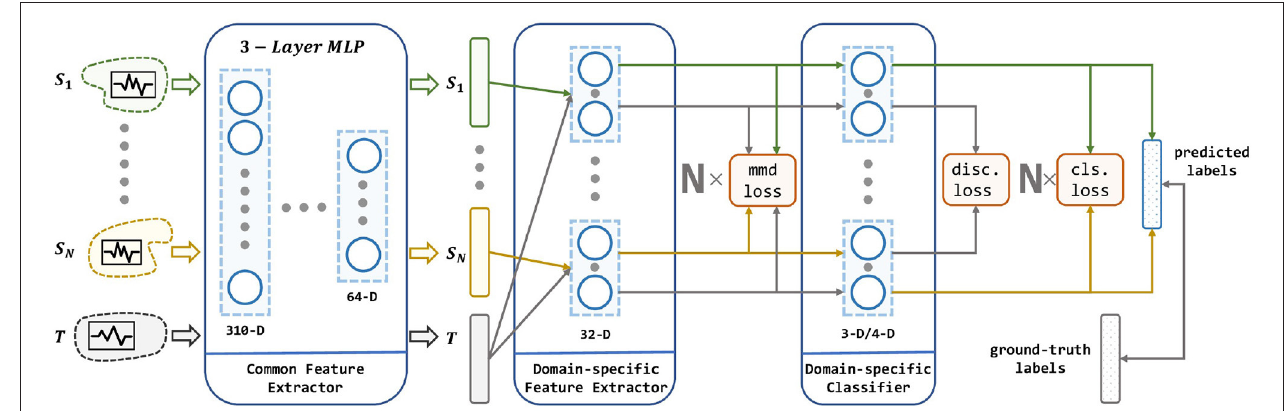
FIGURE 3 | The architecture of our proposed method. Our network consists of a common feature extractor, domain-specific feature extractor, and domain-specific classifier. For each source domain, a branch of DSFE and DSC is conducted for pair-wise domain adaptation. The model receives multiple source domains and leverages their knowledge to transfer to the target domain. Three loss in red squares stands for MMD loss, discrepancy loss, and classification loss which are described in section 4.